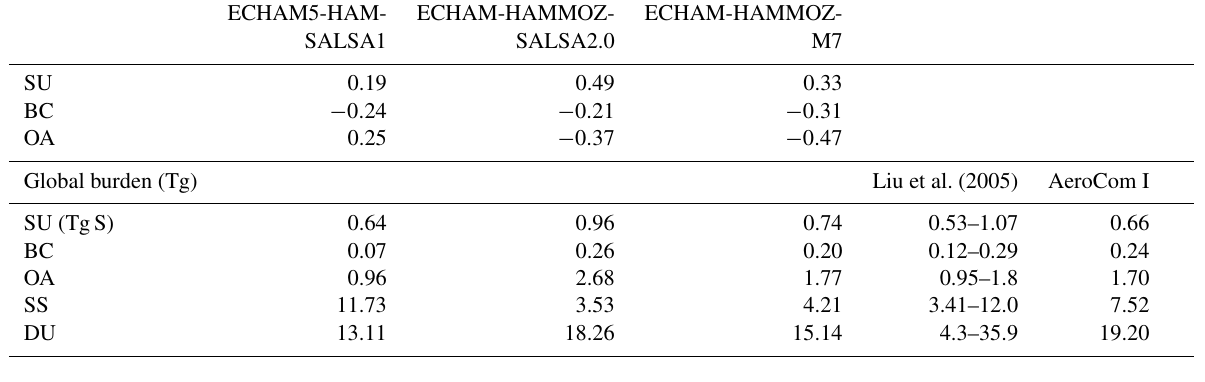
Table 3. Comparison of mean NMB in ECHAM5-HAM (with SALSA1), ECHAM-HAMMOZ (with SALSA2.0), and ECHAM HAMMOZ (with M7) for individual compounds at IMPROVE sites, the global burdens (Tg) of all compounds together with those reported by Liu et al. (2005) and the mean of AeroCom I models analyzed by Textor et al. (2006).